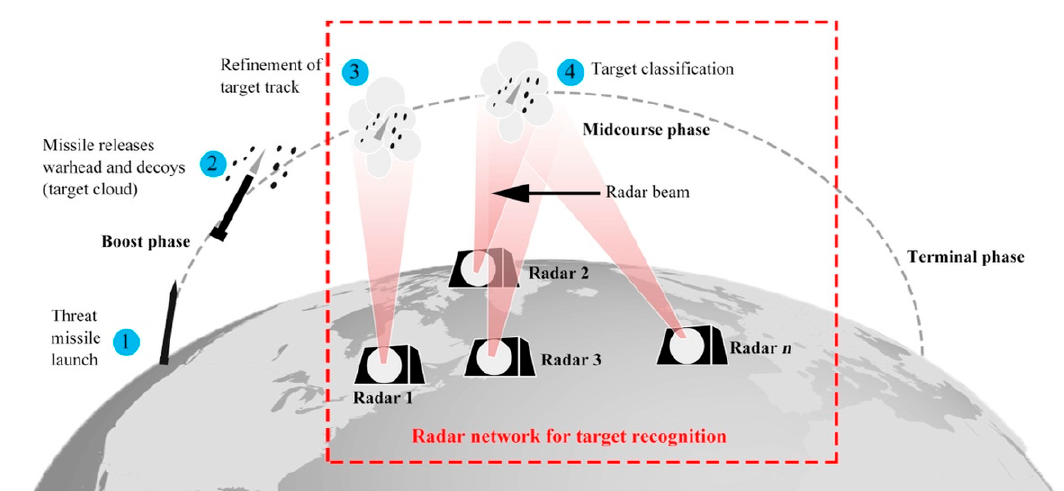
Figure 1. The scenario for a ballistic missile defense system includes a complex, global network of components. (1) The launch of the threat missile is detected by forward-based radars, (2) the threat missile releases its warhead and decoys, (3) the ground-based radar begins tracking the targets, (4) discrimination radars observe the target to try to determine which object is the warhead. The red dashed box highlights the specific functions that are addressed in this paper.